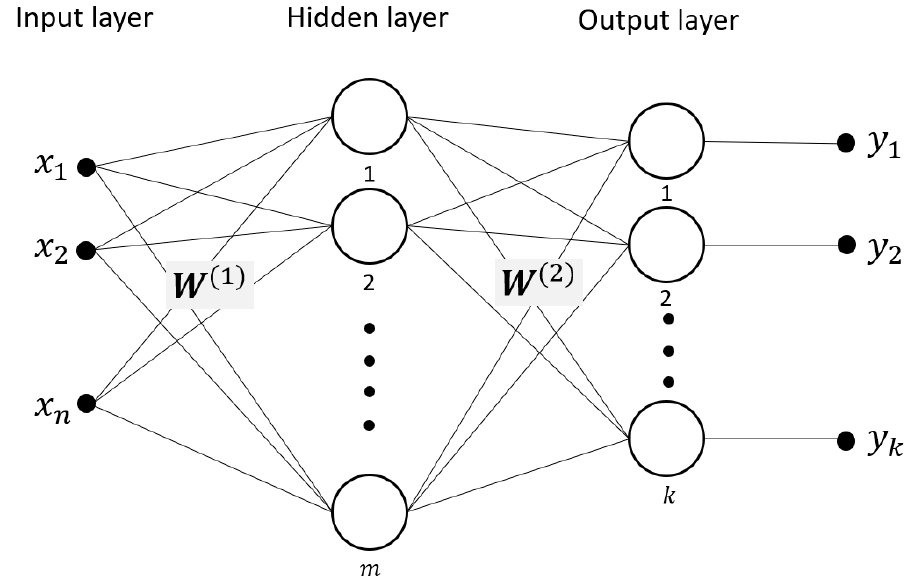
Figure 6. General structure of ANN. Table 3. Configuration of training data.